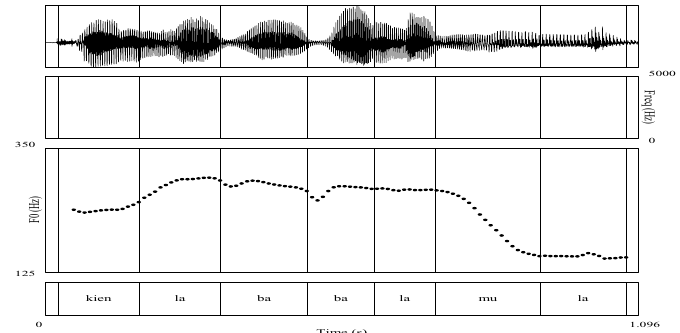
Figure 5. Waveform, spectrogram, and F0 (nuclear falling) contour for ¿Quién lavaba la mula? (Who was washing the mule?). F0 contour divided according to syllable